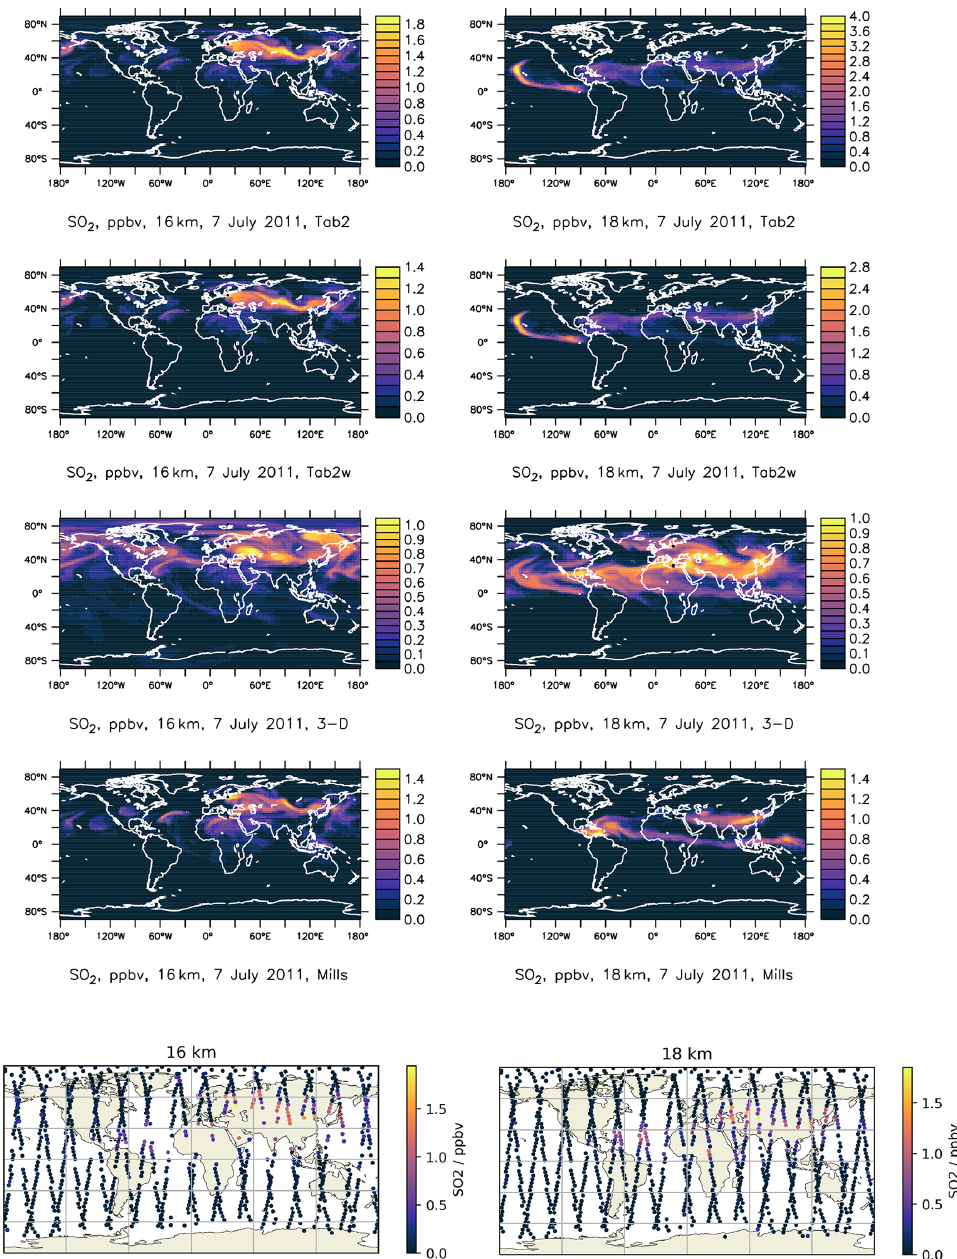
Figure C6. SO 2 mixing ratio (ppb) maps after the Nabro eruption at 16km (left column) and 18km (right column) for the point source of Table 2 in the column between 15.5 and 18km (first row), the column between 14 and 18km (second row), our three-dimensional approach (third row) and the point source assumption of Mills et al. (2016) with a column below 16km (fourth row). Bottom row from MIPAS